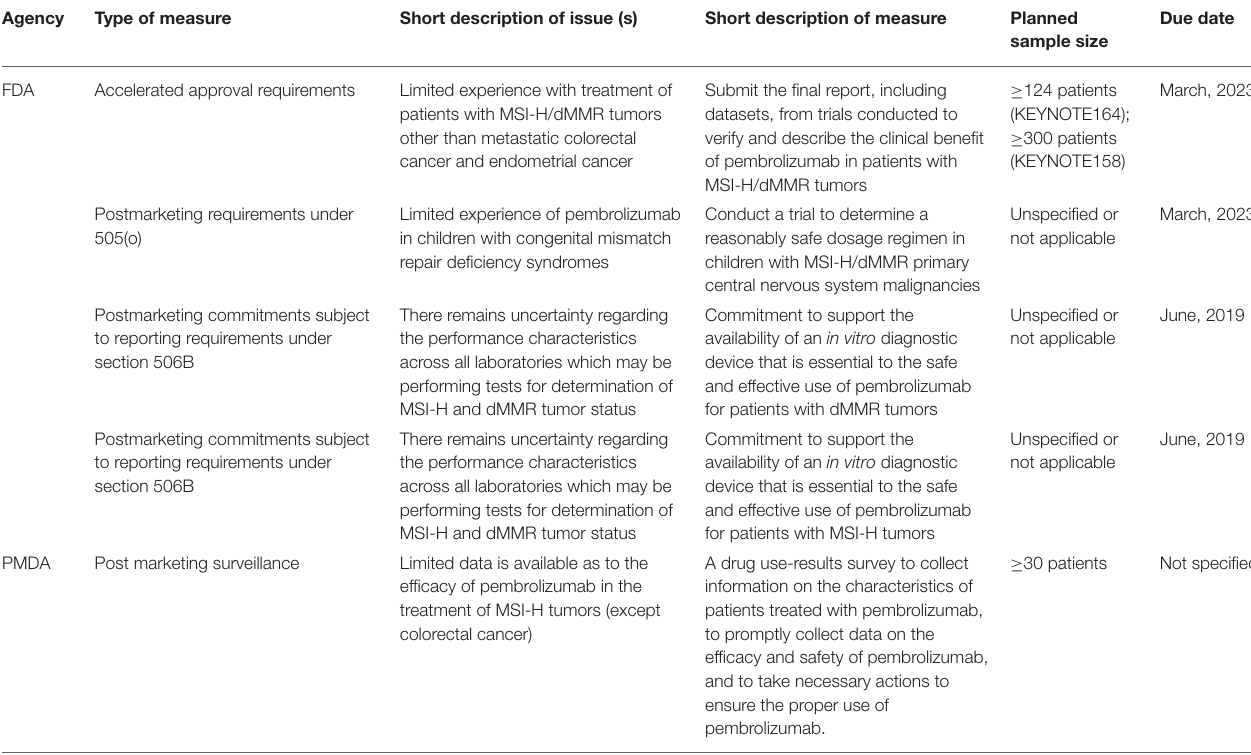
TABLE 4 | Post-marketing measures for pembrolizumab for the treatment of MSI-H/dMMR tumors.